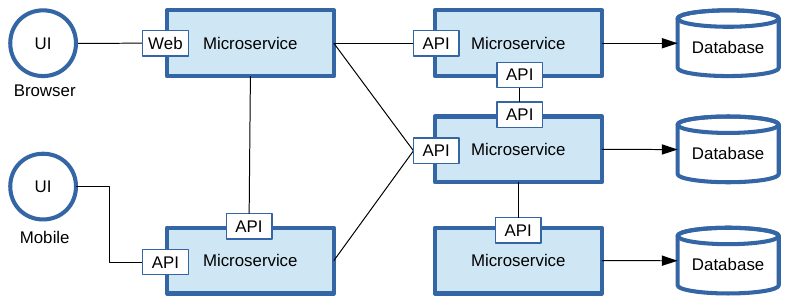
Figure 1. High-level decomposition of a microservice based application with various user interfaces (UI) and application programming interfaces